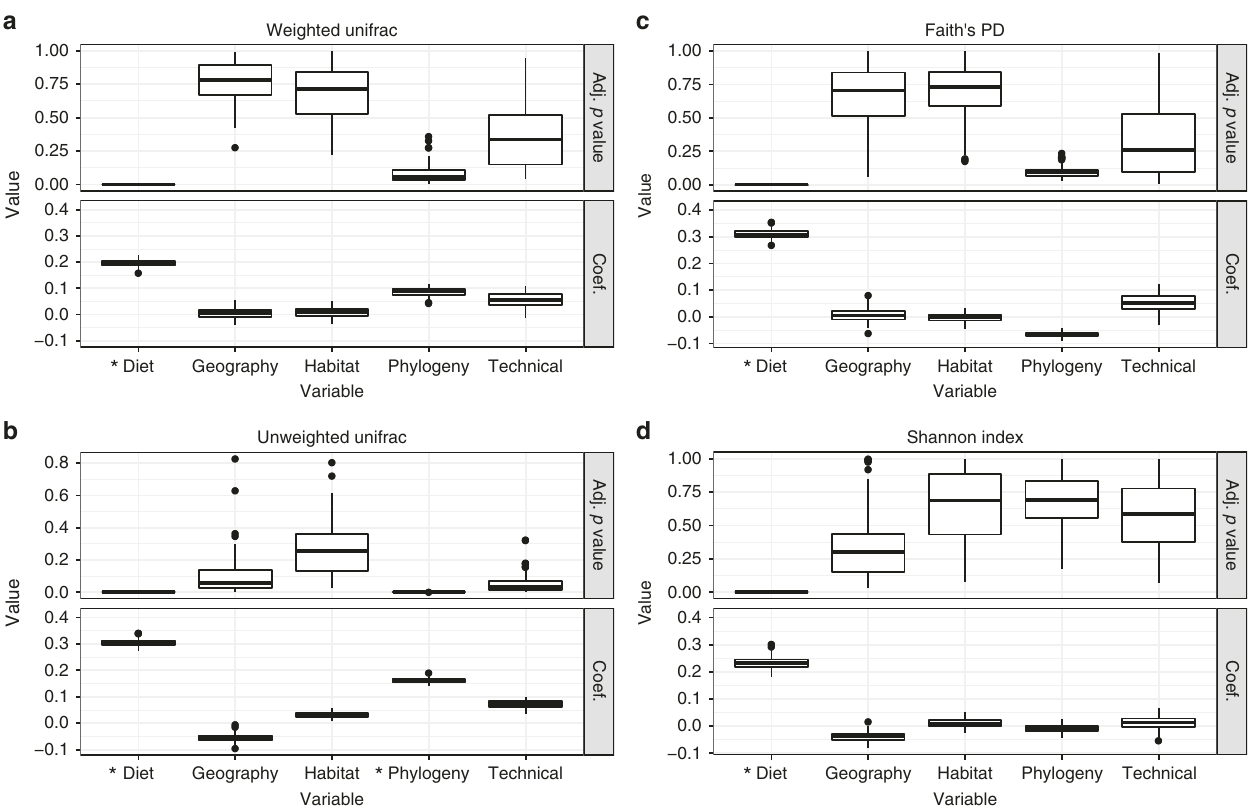
Fig. 2 Host phylogeny and diet signi fi cantly explain the aspects of microbiome diversity. The plots show the BH-adjusted p values (Adj. p value) and partial regression coef fi cients (Coef.) for multiple regression on matrix (MRM) tests used to determine how much alpha- or beta-diversity variance was explained by host diet, geographic location, habitat, phylogeny, and technical parameters (see “ Methods ” ). The boxplots show the distribution of values obtained when running MRM on each of the 100 random dataset subsets, with each subsample comprising just one sample per species. The boxplots show the MRM rho coef fi cient and p value for each subsample. See “ Methods ” for a description of how each distance matrix for the MRM models was generated. Asterisk denotes signi fi cance (Adj. p < 0.05 for ≥ 95% of dataset subsets; see “ Methods ” ). Box centerlines, edges, whiskers, and points signify the median, interquartile range (IQR), 1.5× IQR, and >1.5× IQR, respectively. Source data are provided as a Source Data fi